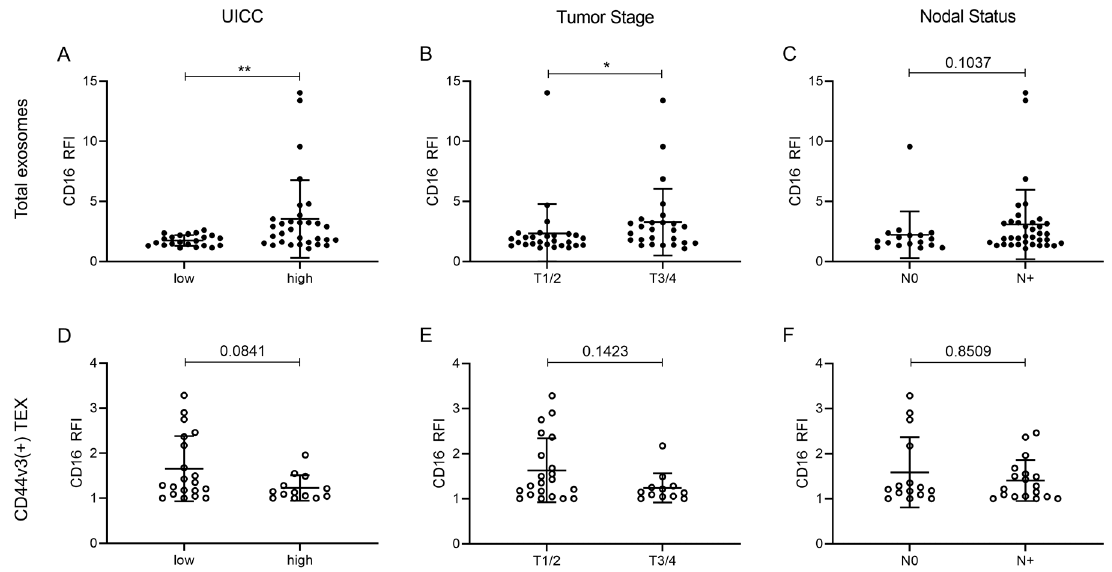
Figure 5. Correlations of CD16 levels on plasma-derived total exosomes and CD44v3( + ) TEX with clinicopathological data. Significant correlations were observed between CD16 levels on total exosomes and UICC status ( A ) as well as tumor stage ( B ). No significant correlation was observed between CD16 levels on total exosomes and nodal status ( C ). No significant correlations were observed between CD16 levels on CD44v3( + ) TEX and UICC status ( D ), tumor stage ( E ), or nodal status ( F ). Results are shown as RFI. Bars represent mean with SD from n = 53 ( A – C ) and n = 33 ( D – F ) HNSCC patients. p values were determined by Mann–Whitney test, with * and ** corresponding to p ≤ 0.05 and p ≤ 0.01, respectively.